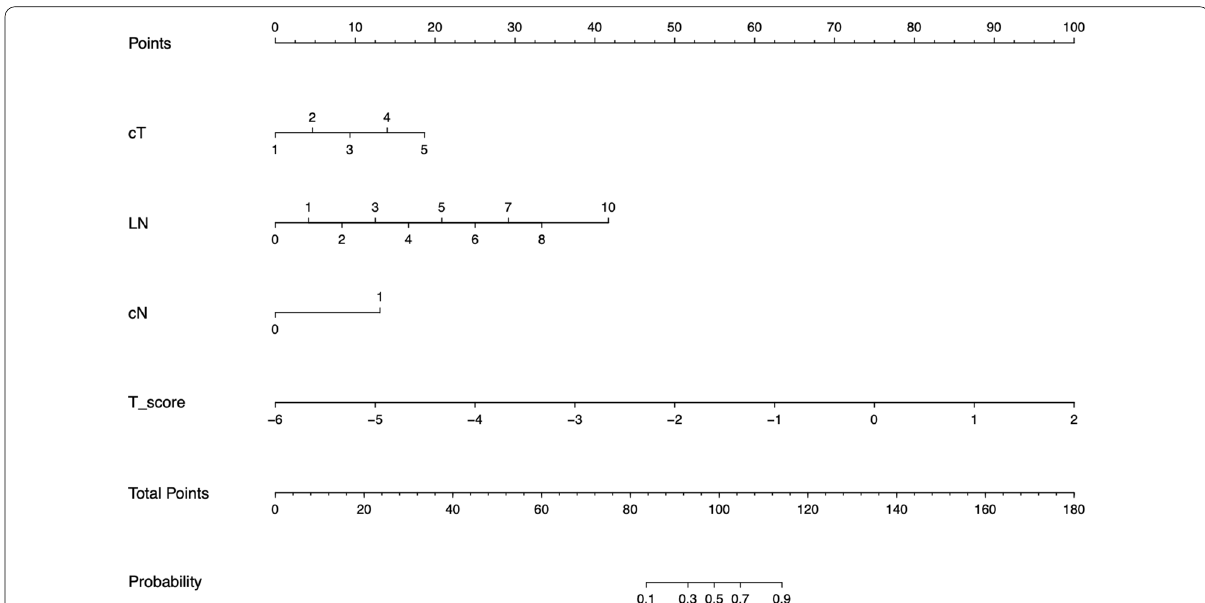
Fig. 3 The nomogram of EMVI assessment model. The nomogram incorporated cT, LN, cN, and T-score. cT, the T stage assessed by radiologists based on MRI; LN, the number of visible regional lymph nodes on MRI; cN, the regional lymph node metastasis assessed by radiologists based on MRI; T-score, the texture score calculated by linear combination of the selected features which were weighted by their respective LASSO coefficients